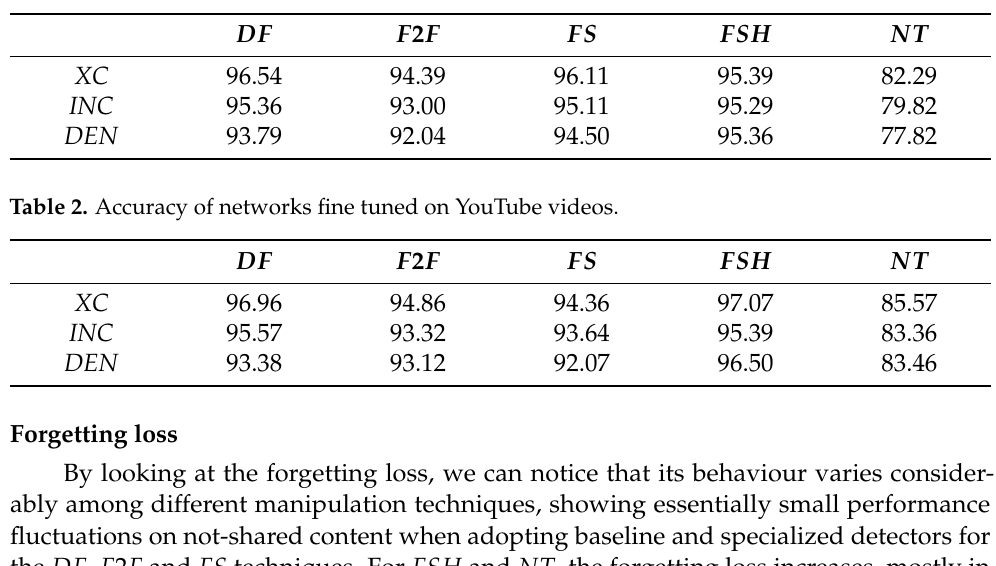
Table 1. Accuracy of networks fine tuned on Facebook videos.